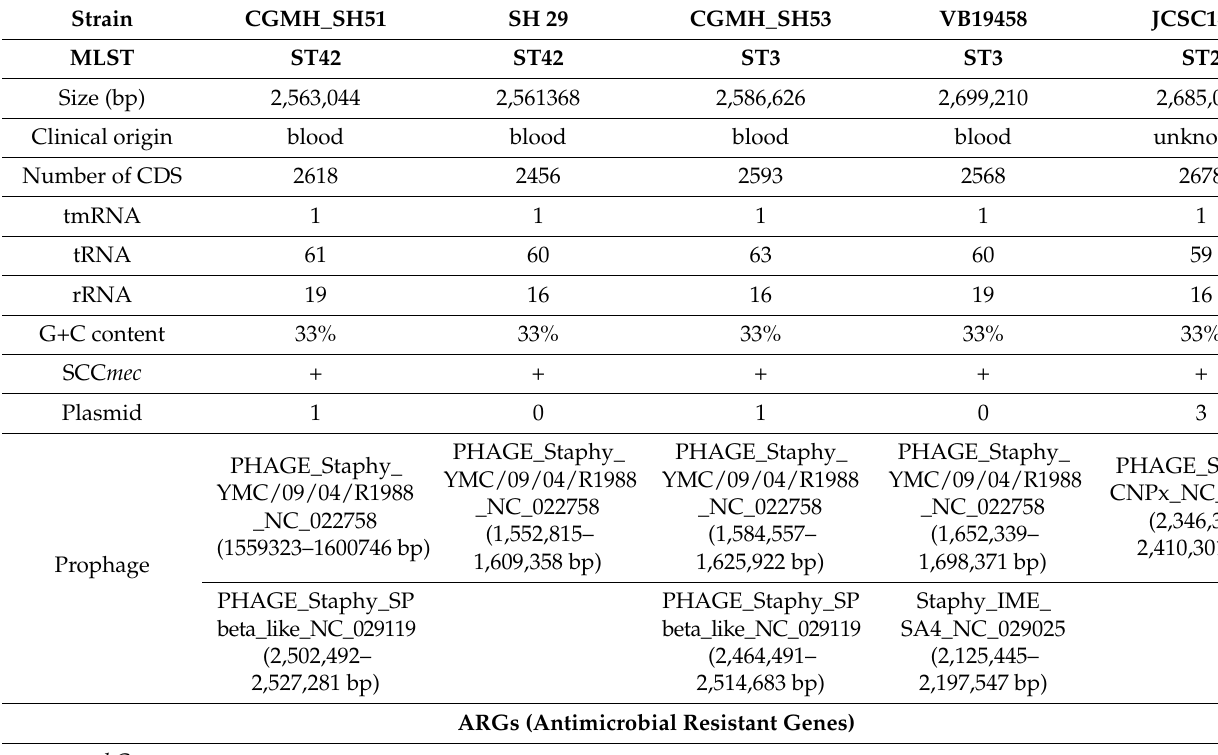
Table 1. General information of WGS analysis of five S. haemolyticus